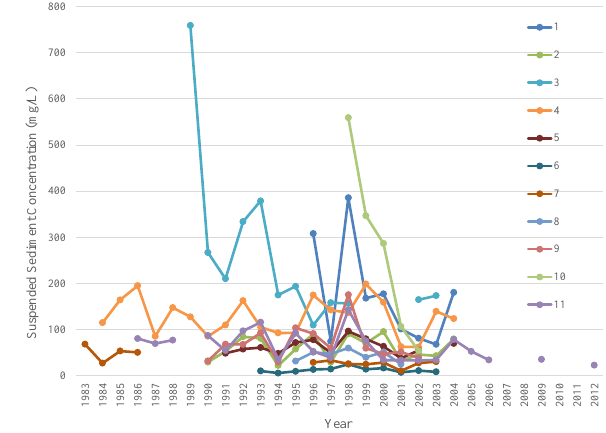
Fig. 2: Comparison of mean annual suspended sediment concentration (mg/L) from different monitoring stations Figure 2. Comparison of mean annual suspended sediment concen- tration (mgL − 1 ) from different monitoring stations.